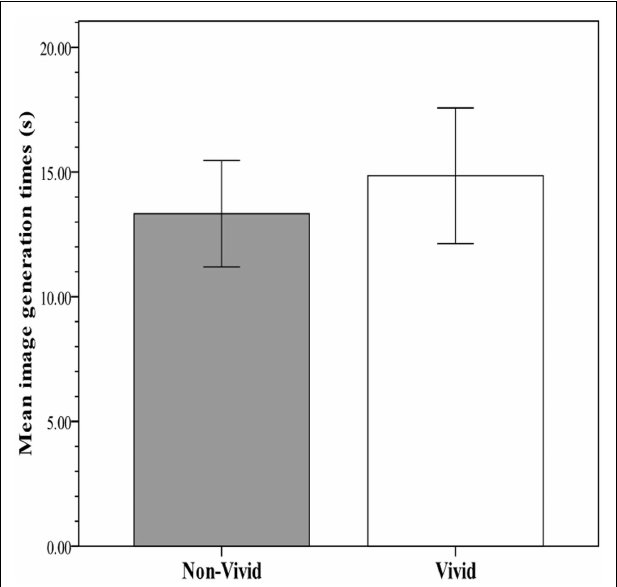
FIGURE 3 | Mean image generation time for verbal cues corresponding to vivid (rating: 5–7) and non-vivid (rating: 2–4) images in Experiment